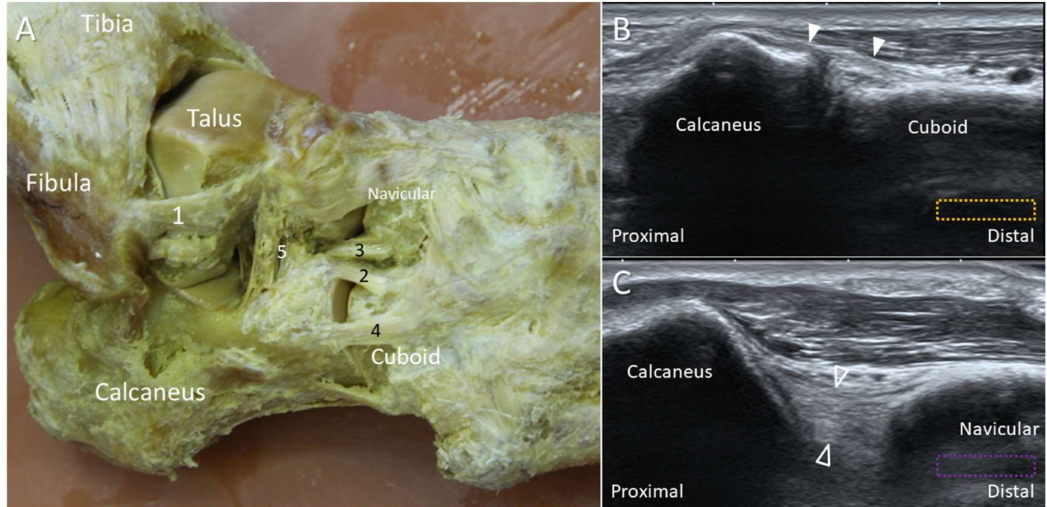
Figure 7. The cadaveric model ( A ) and ultrasound images ( B , C ) of the calcaneocuboid (white arrowheads) and calcaneonavicular (void arrowheads) ligaments. The colored dashed rectangles are in accordance with the transducer positions in Figure 2A. 1: Anterior talofibular ligament (ATFL); 2: calcaneocuboid ligament; 3: calcaneonavicular ligament (CNL); 4: lateral calcaneocuboid ligament; 5: cervical